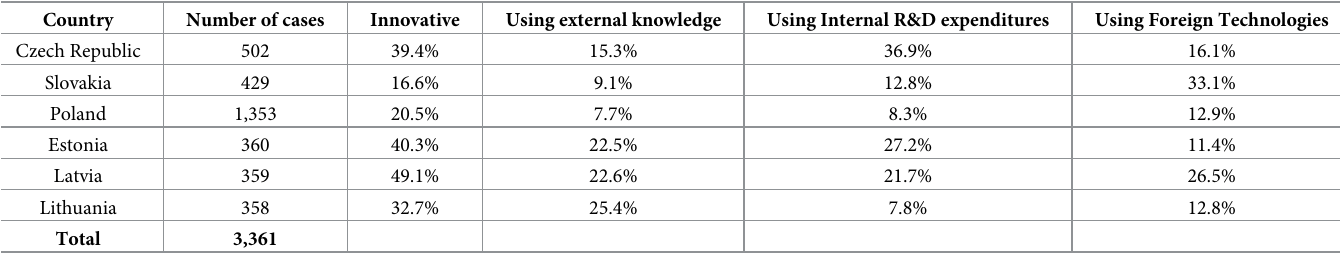
Table 1. Characteristics of analyzed firms in the sample.